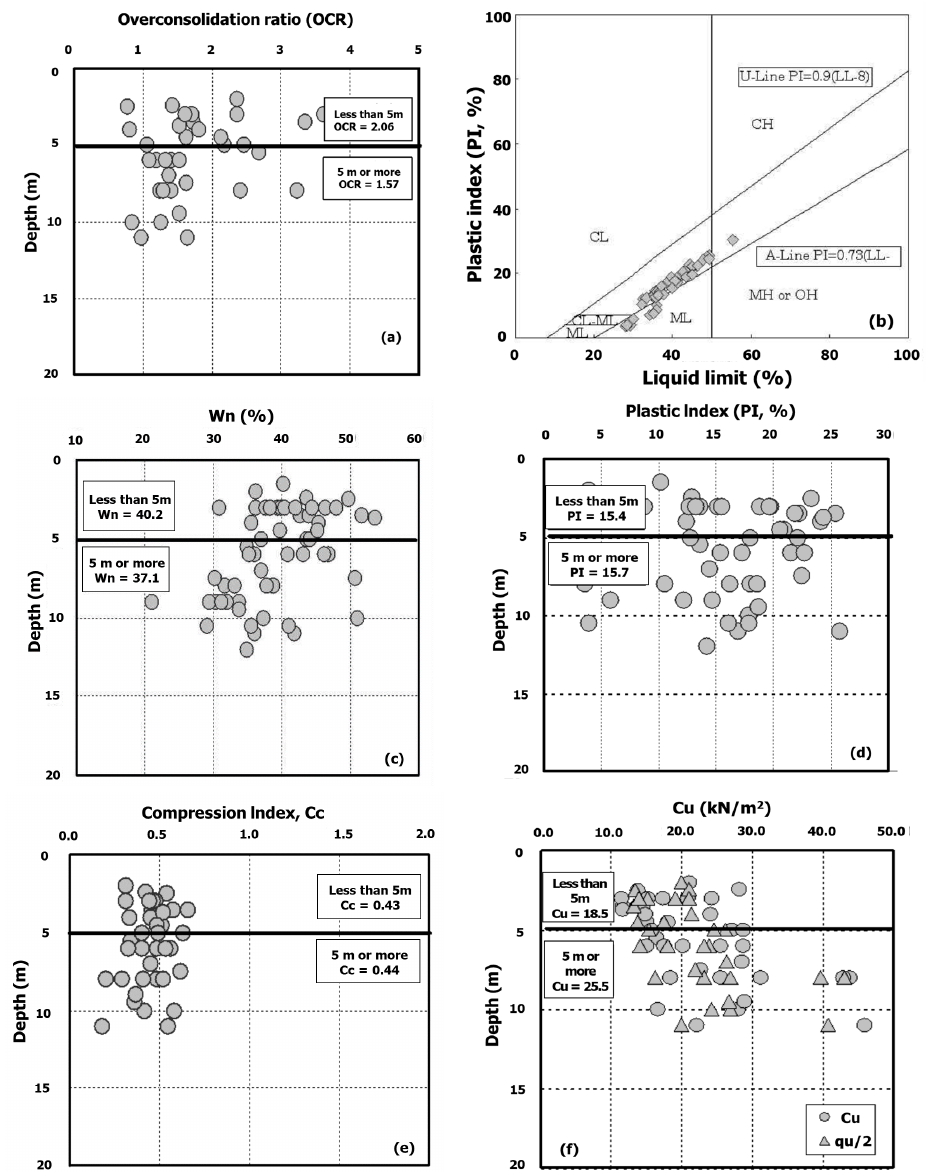
Figure 4. The geotechnical and physical properties of clay. ( a ) over-consolidation ratio; ( b ) plasticity chart; ( c ) natural water content; ( d ) plasticity index; ( e ) compression index; ( f ) undrained shear strength.